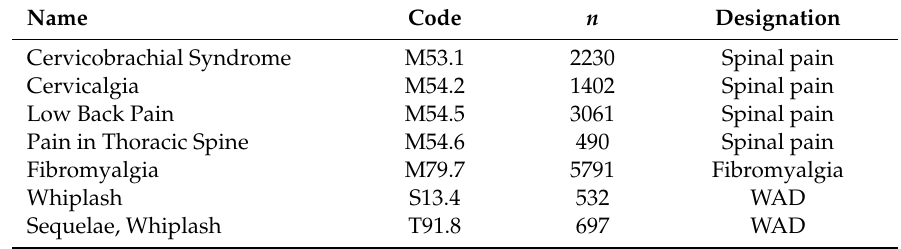
Table 2. ICD-10-SE codes, number of patients for each code and the designation groups in the present study for the reference groups of chronic pain patients without Ehlers–Danlos syndrome or Hypermobility syndrome (EDS /